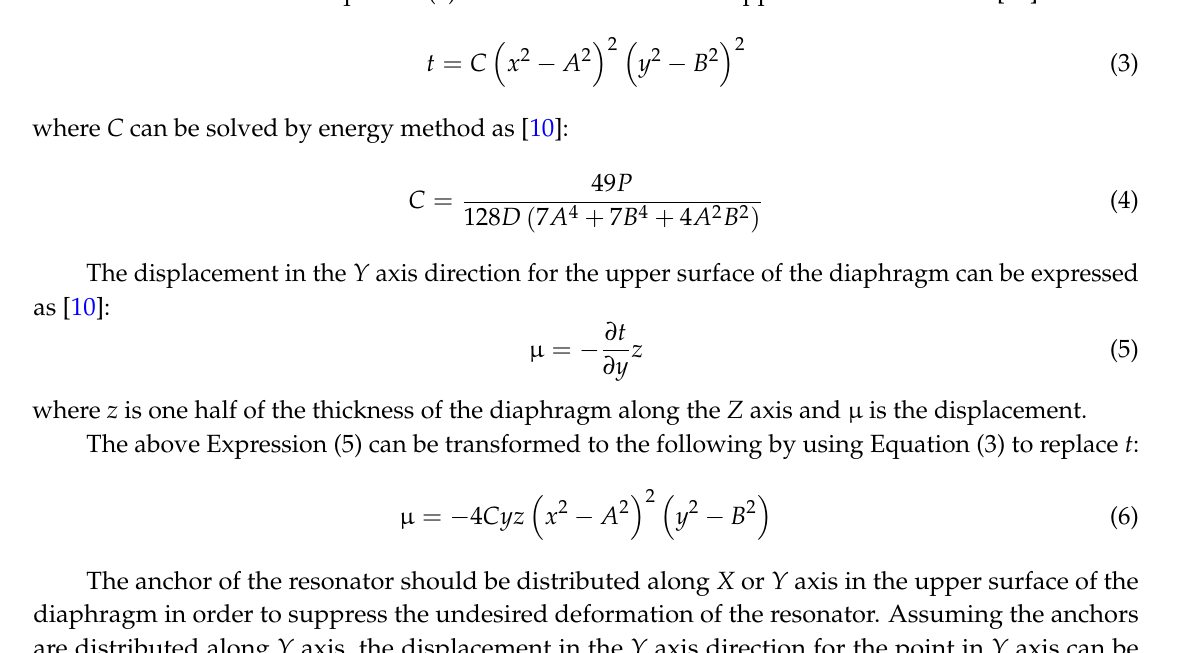
Figure 3. The schematic drawing of the pressure sensitive diaphragm.